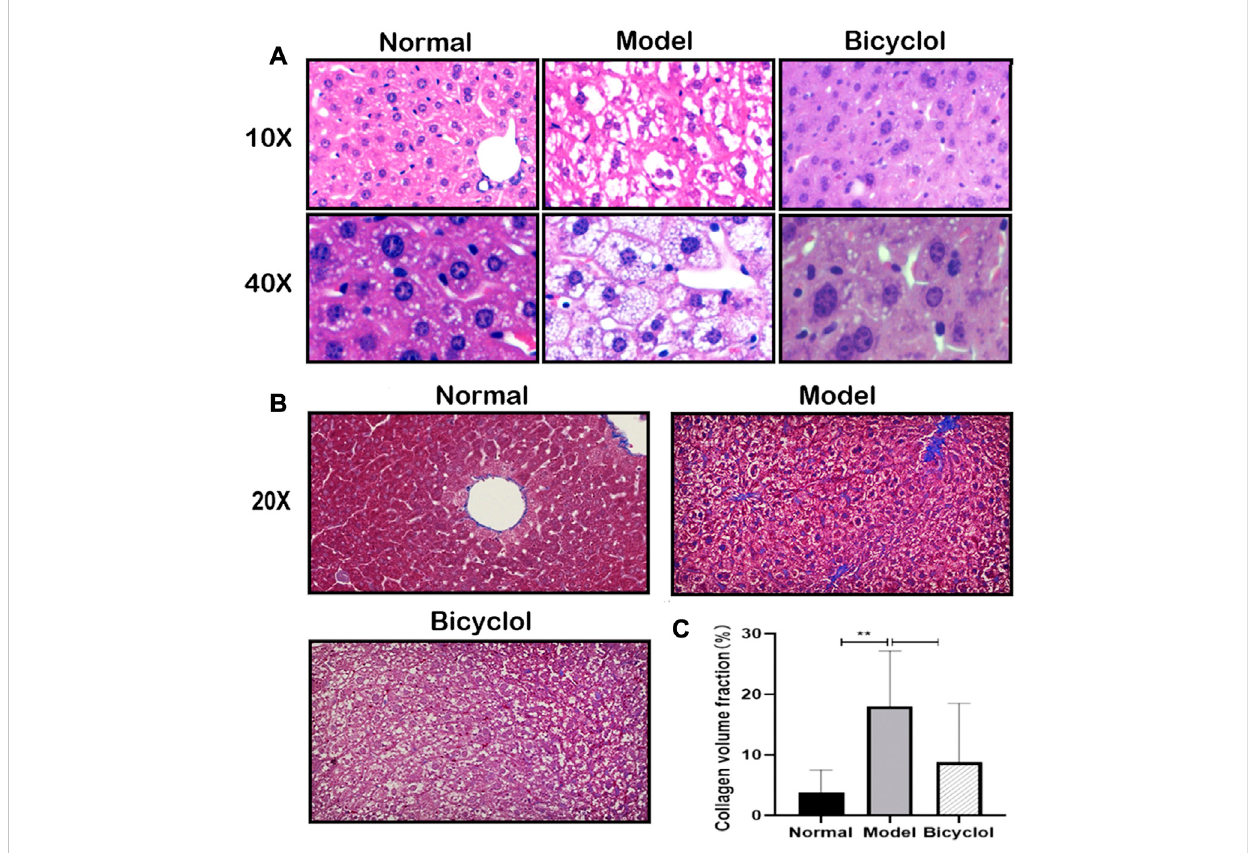
Effect of bicyclol on HFD feeding induced fatty and fi brotic liver. (A) Liver representative pathology images of H&E staining (scalebar, 100um for ×10magni fi cation, 20p.m. for ×40magni fi cation). (B) Liver representative images of Masson staining (scalebar, 40p.m. for ×20magni fi cation). (C) CVF in the liver sections (n = 6).** p < 0.01 vs